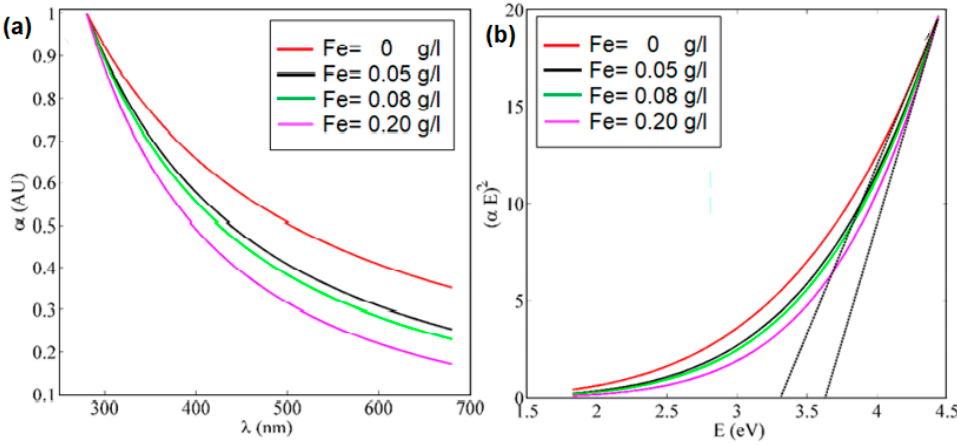
Figure 8. ( a ) Absorbance dispersion curve of in-situ gold-ceria NPs at different iron concentrations, and ( b ) the corresponding bandgap calculations.